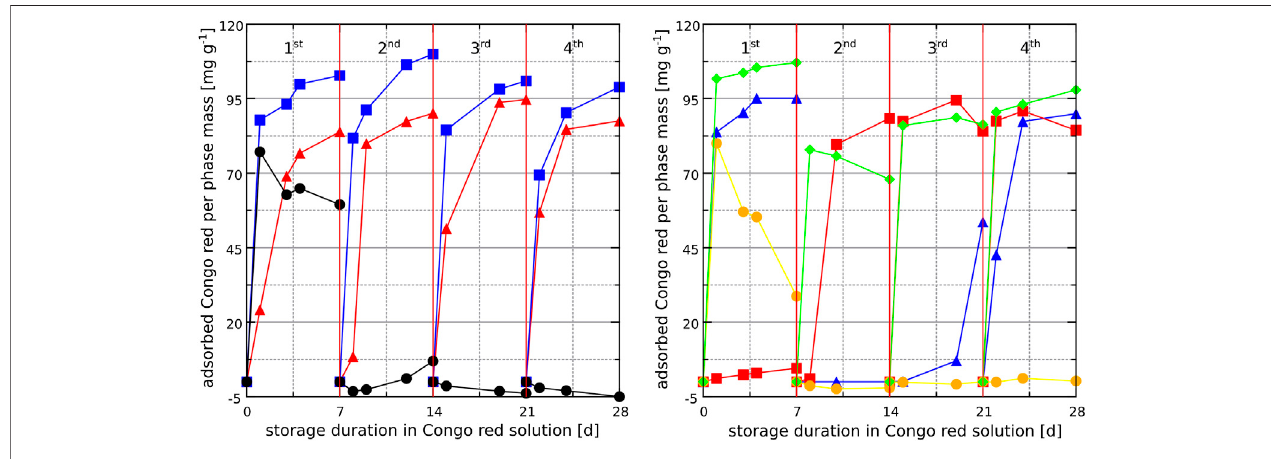
FIGURE 9 | Removal of Congo red from aqueous solutions in contact with different individual phases, based on photometry results for four consecutive exposure cycles. Left: hydrotalcite( ▲ ),Friedel ’ s salt( ■ ) and powderedactivated carbon( C ). Right: portlandite ( ▲ ),calcite ( ■ ), gypsum( C ) and calcium silicatehydrates (C-S-H)( ◆ ).